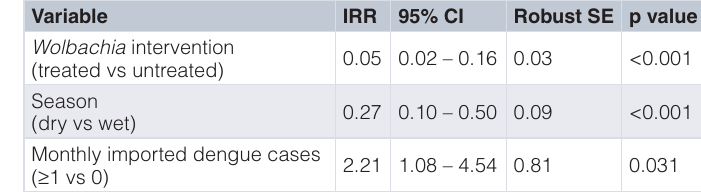
Table 5. Model estimates from negative binomial regression of monthly locally-acquired dengue case counts in Wolbachia -treated vs untreated populations, adjusted for temporal autocorrelation within each transmission